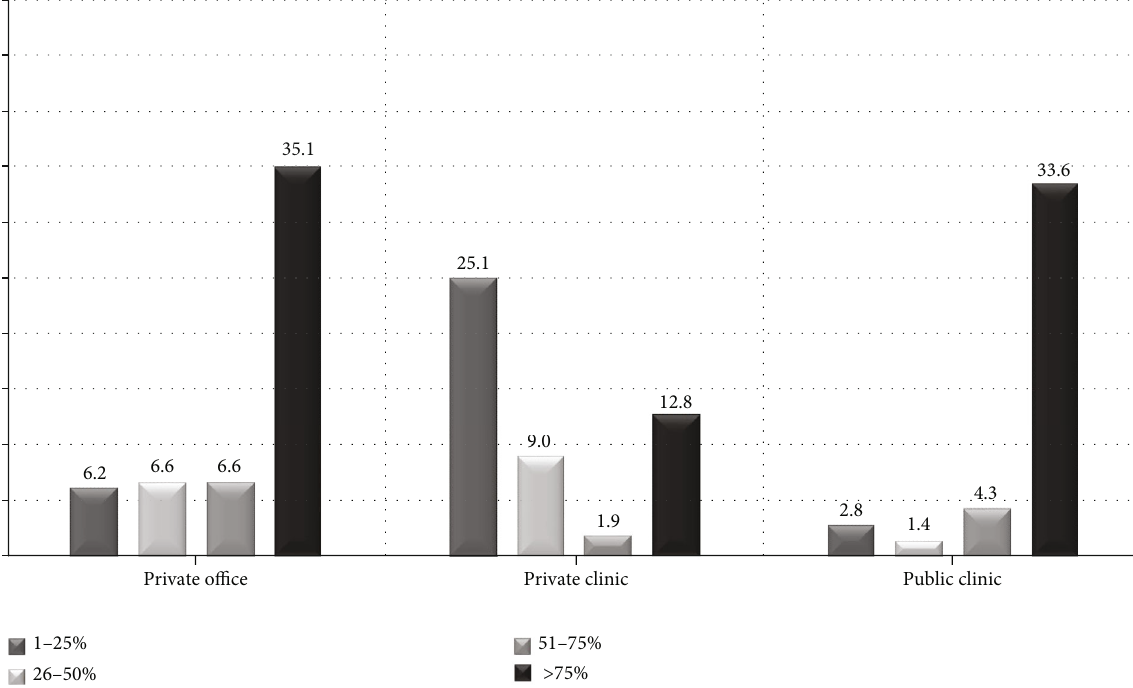
Figure 3: Participants ’ workload by setting (private o ffi ce, clinic in private hospital, and clinic in public hospital). Data are expressed as percentage according to prede fi ned ranges (0%, 1-25% of procedures, between 26 and 50%, between 51 and 75%, and over